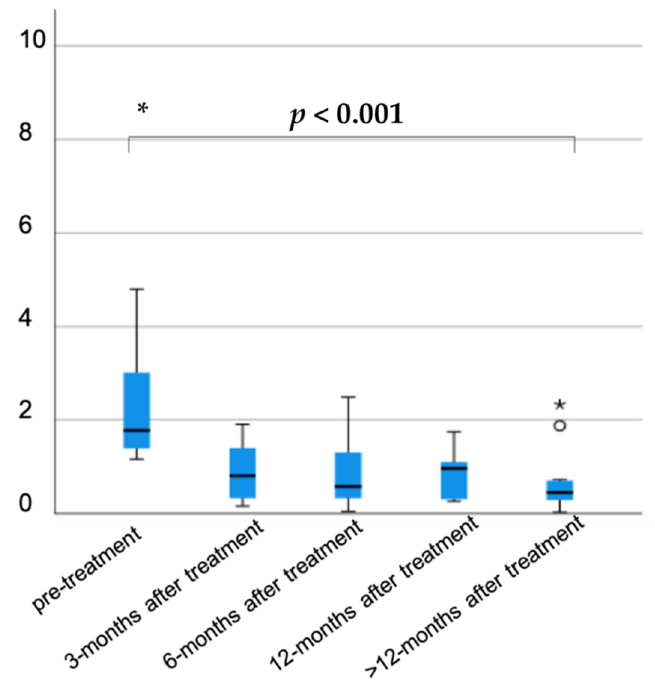
Figure 5. S. stercoralis IgG index during follow-up, according to treatment. Treatment with ivermectin was repeated in 8/49 patients (16.3%) due to a positive titer at 3 (2/8, 25%), 6 (3/8, 37.5%), and 12 months (2/8, 25%) after the first drug administration. Two of them (2/8, 25%) became negative for strongyloidiasis whereas the other 6/8 were lost to follow-up without retesting the serologic test. Among them, 2/8 (25%) were also tested for HTLV infection, and both turned out to be negative. HIV serology was required only as part of screening for adoptees and immigrants, and none of the enrolled patients were